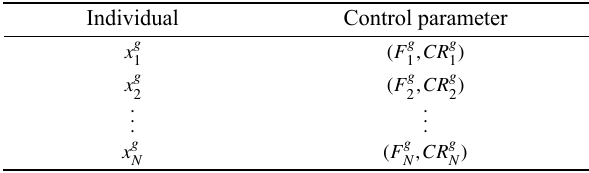
Table 1 Individual with control parameters.